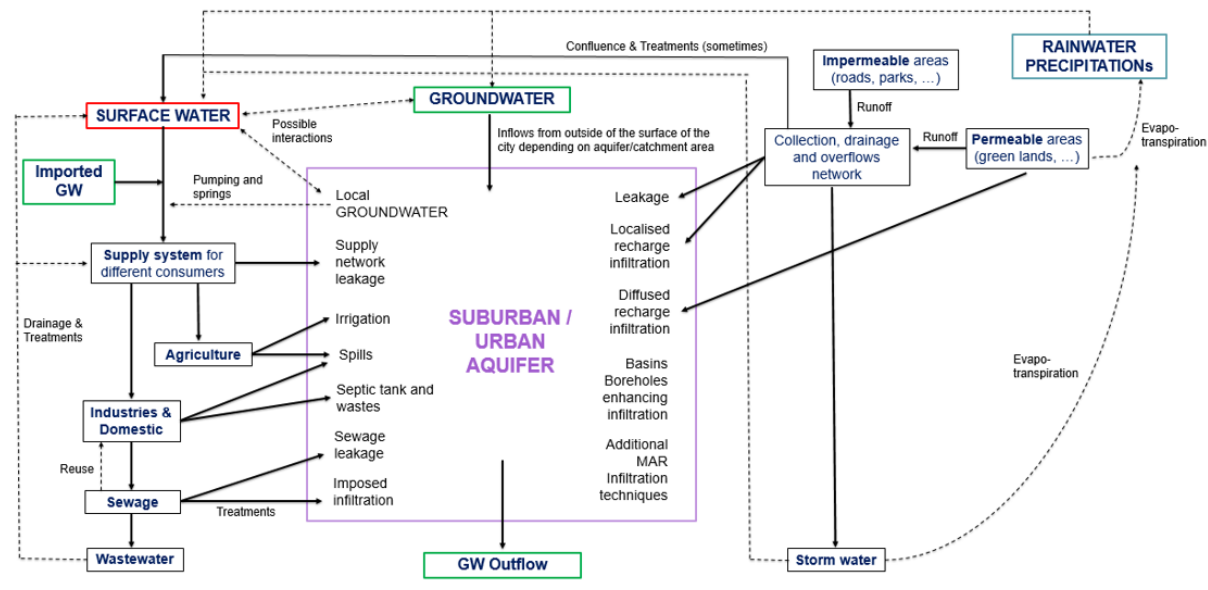
Figure 1. Schematic view of the urban water cycle (modified from Wei et al., 2018; Barret et al., 1999).